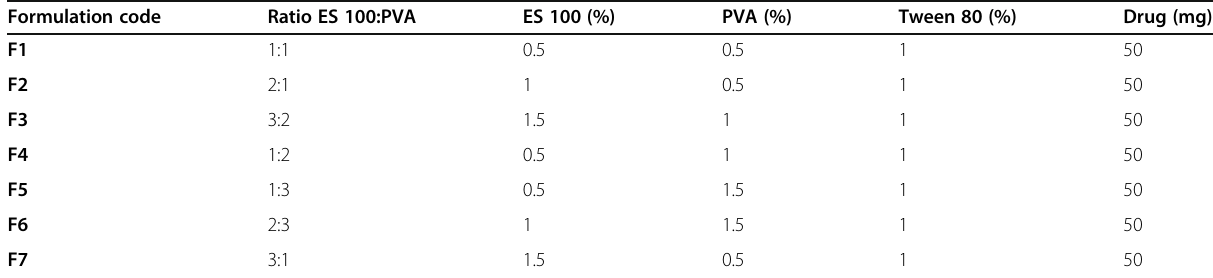
Table 1 Formulation composition of ES 100 nanoparticles Formulation